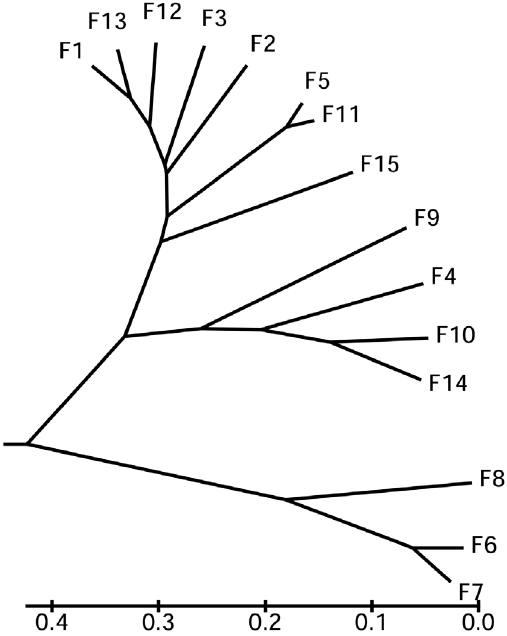
Figure 4. A serum titer clustering tree of 15 different farms based on average serum titers to orf. The phylogenetic relationship was constructed by using the NJ program of MEGA version